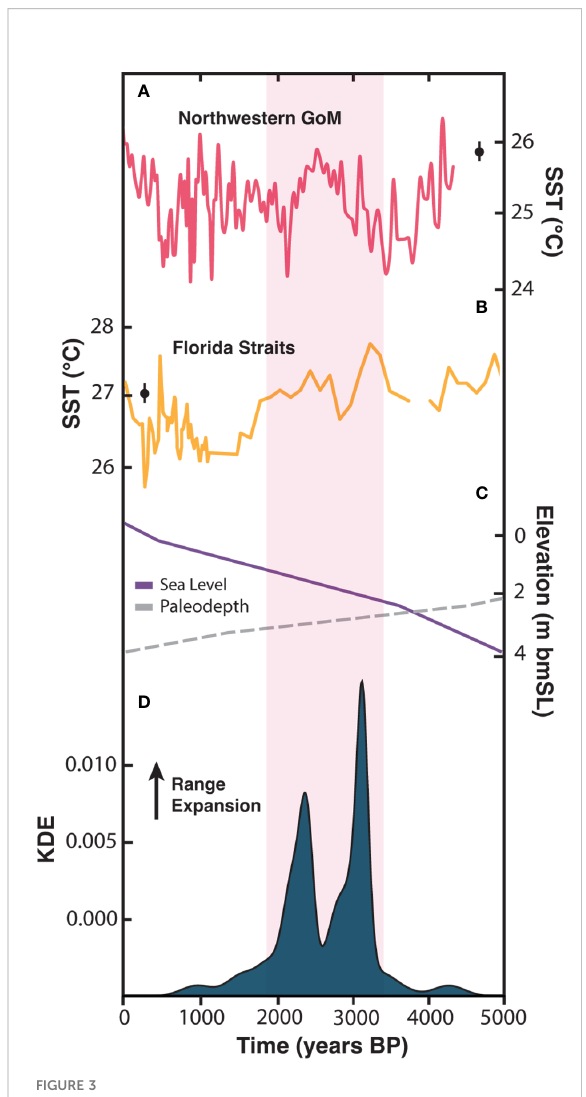
FIGURE 3 Comparison between late Holocene reef growth on the nearshore ridge complex (NRC) off southeast Florida, sea level, and sea-surface temperature (SST) variability in the subtropical western Atlantic. SST reconstructions from (A) the Garrison Basin in northwestern Gulf of Mexico (GoM) [Thirumalai et al., 2021] and (B) the Florida Straits (SST composite created from records near the Dry Tortugas [Lund and Curry, 2004] by Thirumalai et al., 2021). Modern observations of mean-annual SST at each location are indicated by black dot with error bars (error bars indicate standard deviation over 1970 — 2010 CE; SST was taken from HadISST, Rayner et al., 2003). (C) Estimated late Holocene relative sea level from Khan et al., 2017 and calculated paleo- water depths (see Supplementary material). (D) Kernel Density estimate (KDE) distribution of the 40 U-Th ages obtained from Acropora palmata and Orbicella spp. samples at study site. Pink shaded bar shows relative warming in both records and overlap with reef